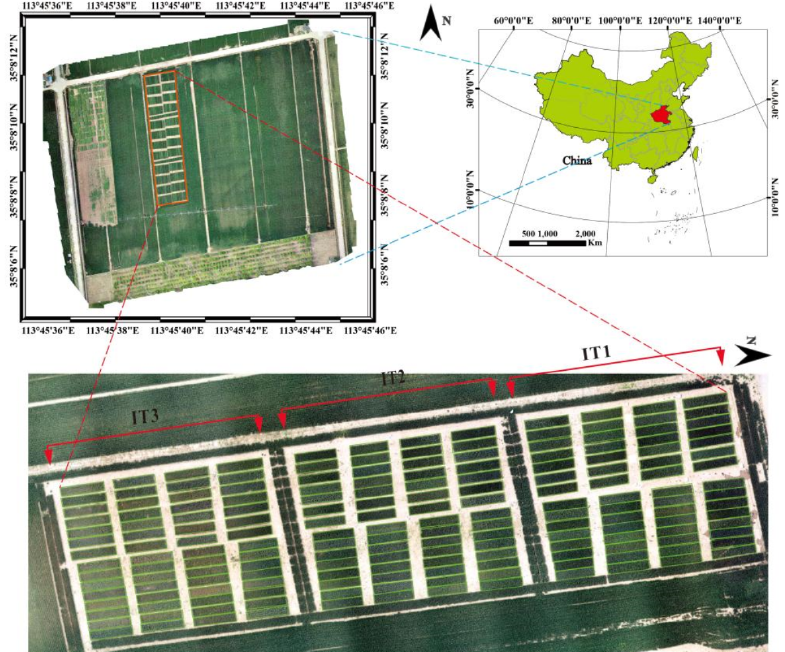
Figure 2. Distribution of test sites and test plots. IT1: high irrigation; IT2: moderate irrigation; IT3: low